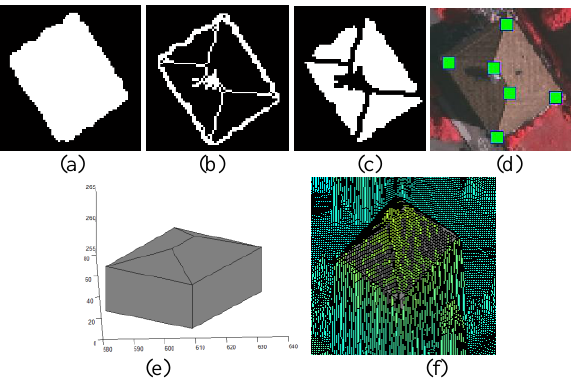
Figure 10: The reconstructed building, (a) detected parcel, (b) ridge line with boundary, (c) separated planes of roof, (d) the roof corners, (e) 3D model, (f) Reconstructed 3D model on range image of LiDAR